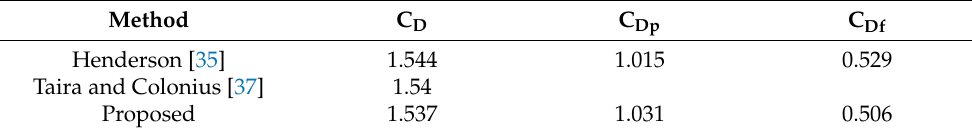
Figure 11. Time history of lift and drag coefficients ( Re = 40). Table 2. Comparison of drag coefficients ( Re = 40).